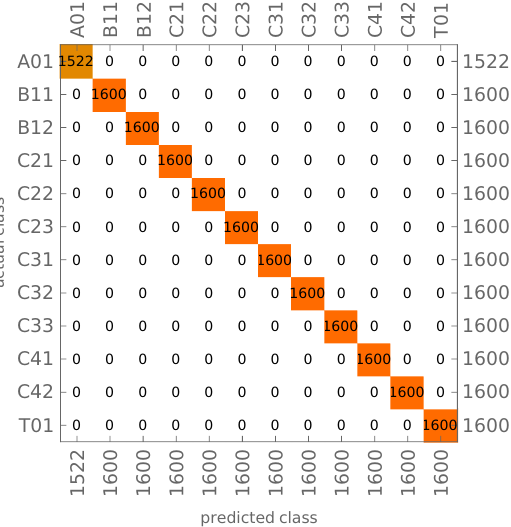
to E 1 = 113.52 GPa and E 2 = 10.73 GPa (while the original moduli were E 1 = 141.9 GPa, E 2 = 9.78 GPa). The results of mode shapes identification are shown in Figure 6; the angles cases for each n ). The results shown in Figure 6 prove that the CNN trained on a mode shapes for a structure made of a different material.